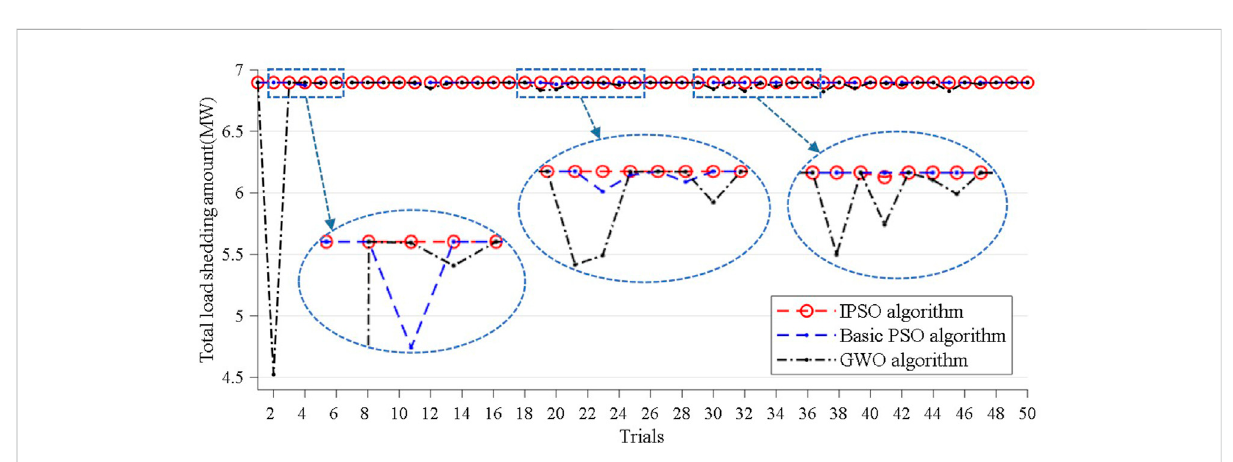
FIGURE 7 Comparison results of the total load shedding amount of three algorithms under 50 independent